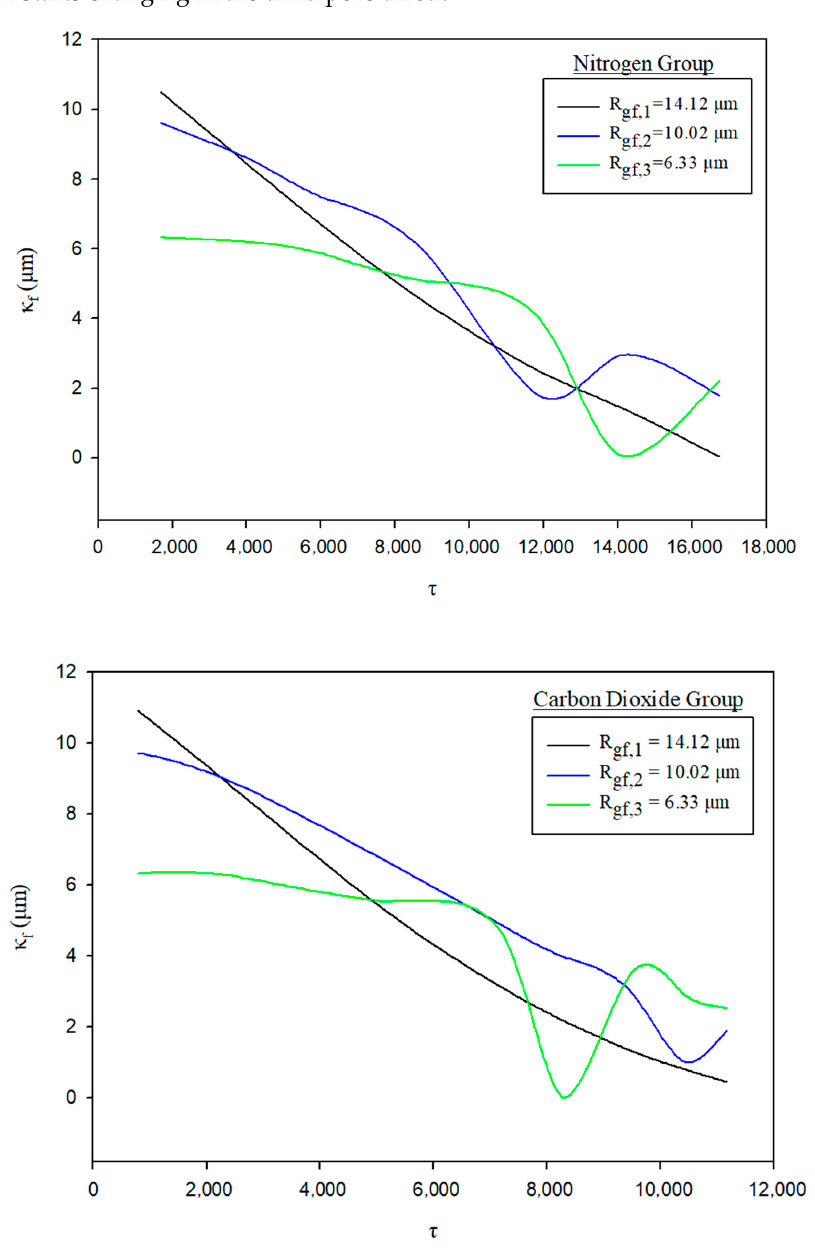
Figure 11. Simulated Interface Radius Matching for Continuously Tapering Pore Throat. The relative contrast curves of the two experimental groups and the liquid-gas inter- face descending curves in Figure 11 are very similar for each pore throat. When the inter- face radius value ( κ f ) from each pore throat in these two groups is compared, the nitrogen group’s lines are closer together, while the carbon dioxide group’s lines have a steeper decreasing slope. This change is consistent with the results observed by real-time visuali- zation (Figure 10). The gas snap-off of the carbon dioxide group occurred earlier than that of the nitrogen group. At the same time, the liquid imbibition process of the nitrogen group is more stable than that of the carbon dioxide group, which indicates the gas-liquid interface fluctuation is lower. The corresponding images for the simulation results are shown in Figure A2 in the supplementary section.